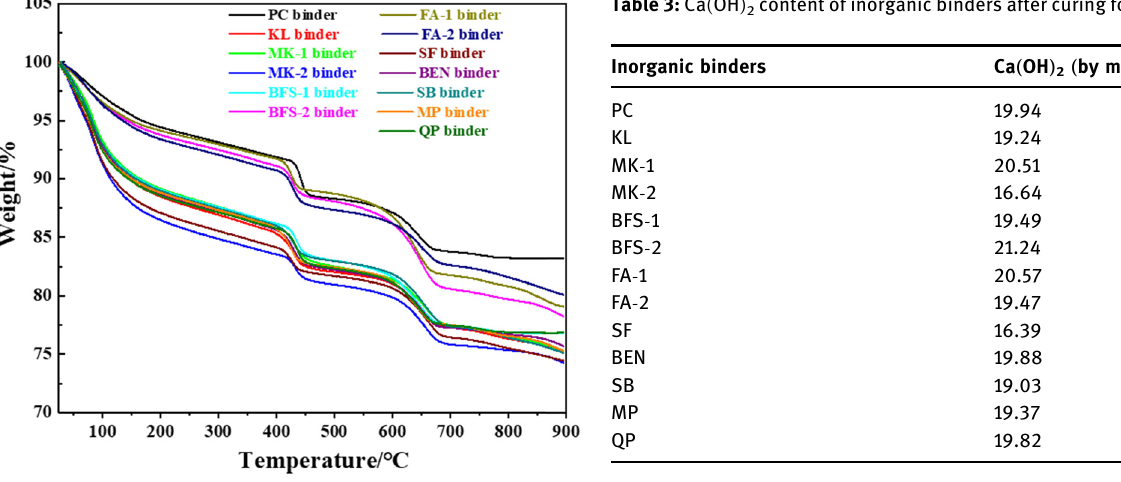
Figure 9: TGA curves of inorganic binders.